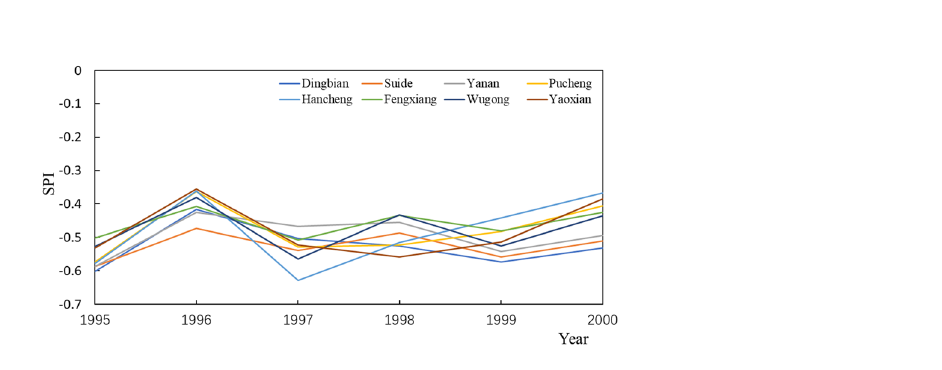
Figure 5. SPI changes at each site from 1995 to 2000.